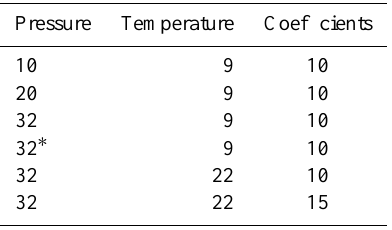
Fig. 9. Theoretical error profiles corresponding to the profiles in Fig. 8 (except for 0.0): Errors are within a reasonable range for the selected Tikhonov value of 3.5. Table 1. Pressure, Temperature and Coefficients Database Grids: ESFT retrieval was performed using different pressure, temperature and coefficients